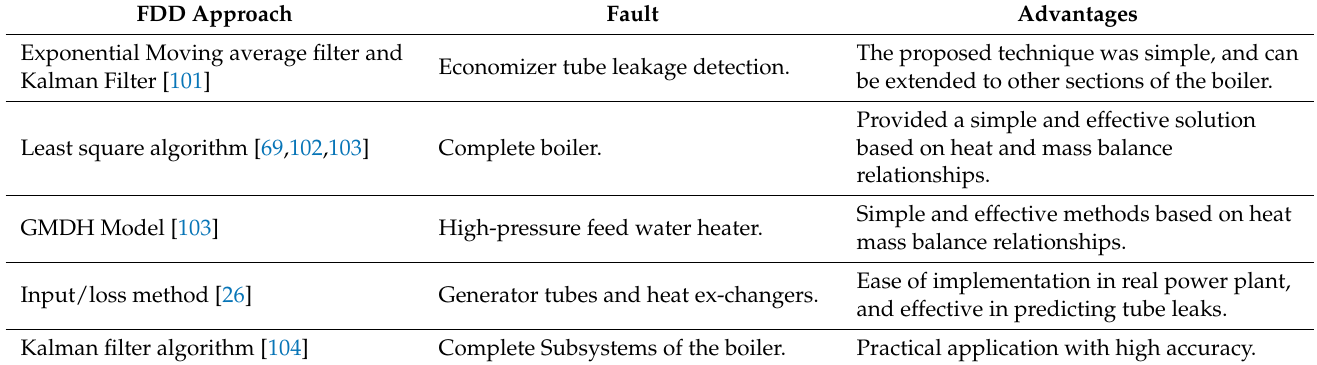
Table 4. Comparison of Model-based Fault Detection Techniques for Boiler water wall tube leakage